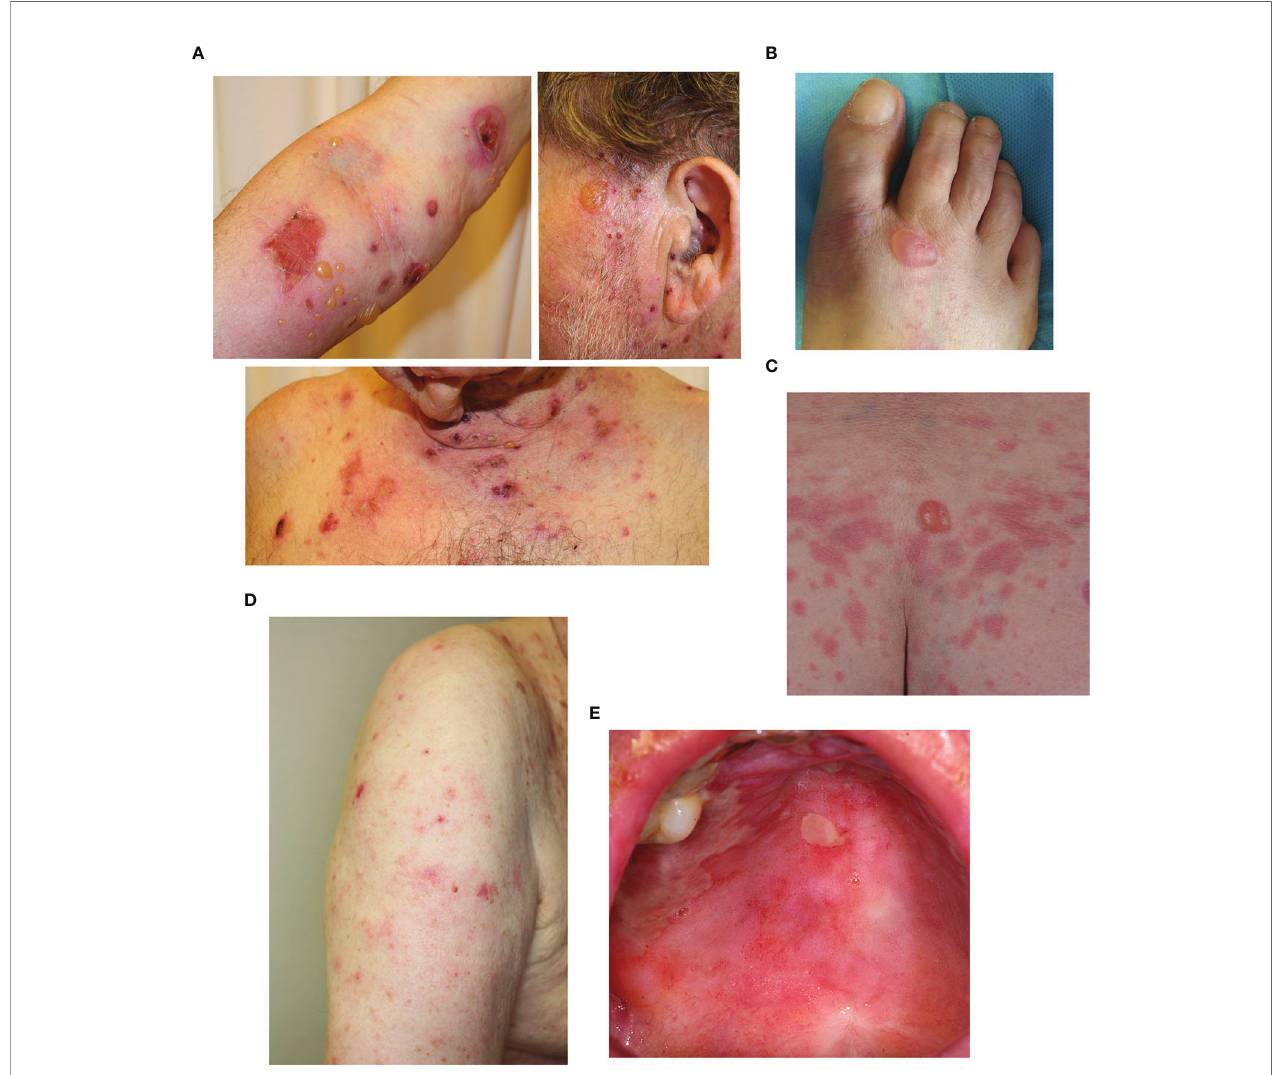
FIGURE 2 | Examples of clinical manifestations of cases diagnosed as bullous pemphigoid (BP) under CI therapy. (A) Patient presenting with erythematous urticaria and tense blisters and erosions scattered over larger areas of the body, typical for classical BP. Patients presenting with (B) a single blister and (C) a single blister and erythematous urticaria. (D) Eczematous skin changes. (E) Oral mucosal